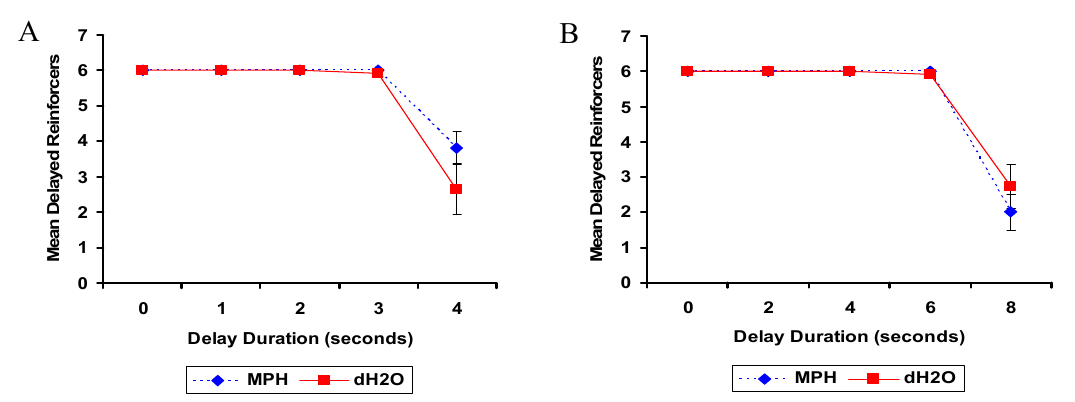
Figure 5. SHR: Mean (±SEM) delayed reinforcers attained in Test 1 to 7 ( A – G ) of the Delayed Reinforcement Task by rats previously exposed to 4 weeks of methylphenidate O) treatment. One test was conducted each (MPH, 2 × 2 mg/kg/day) or distilled water (dH 2 day over a period of 7 days (15–21 days